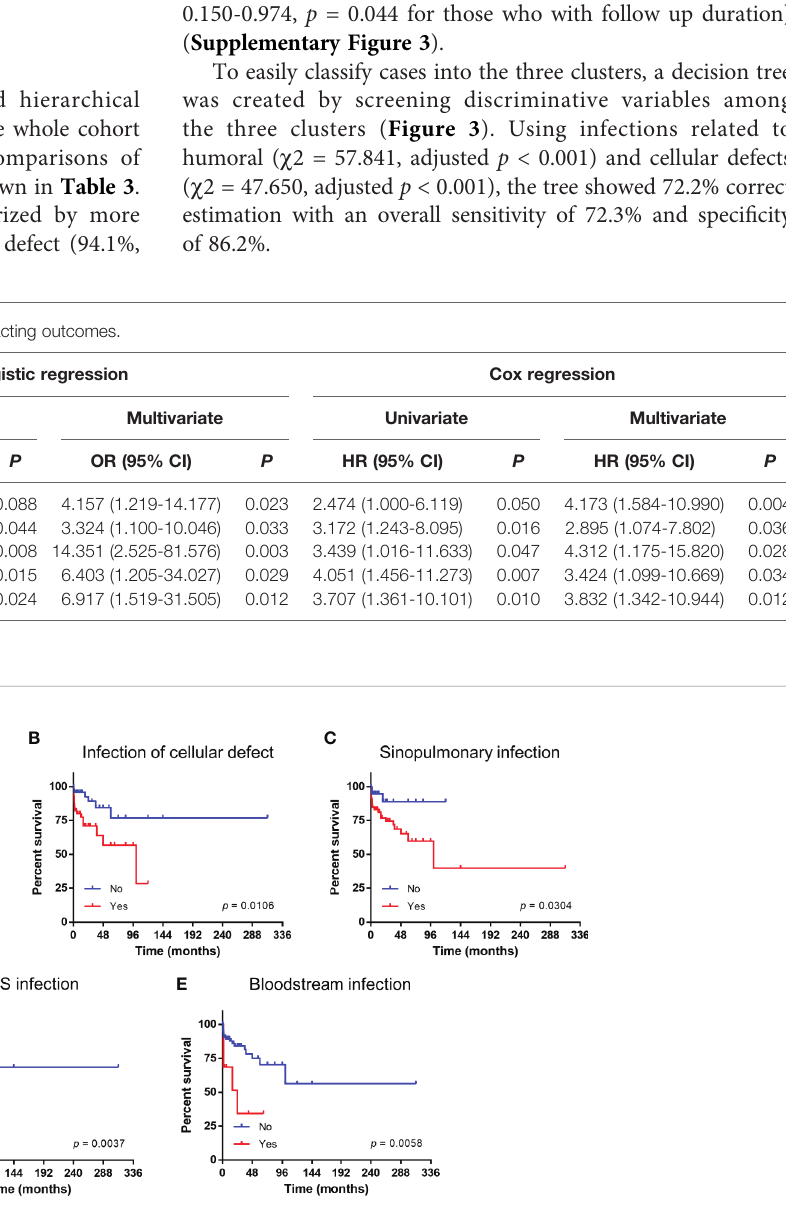
FIGURE 1 | Kaplan-Meier survival curve of patients with Good syndrome strati fi ed according to prognostic factors. (A) Thymoma status. (B) Infection related to cellular immunity defects. (C) Infection of sinopulmonary tract. (D) Infection of central nervous system (CNS). (E) Infection of